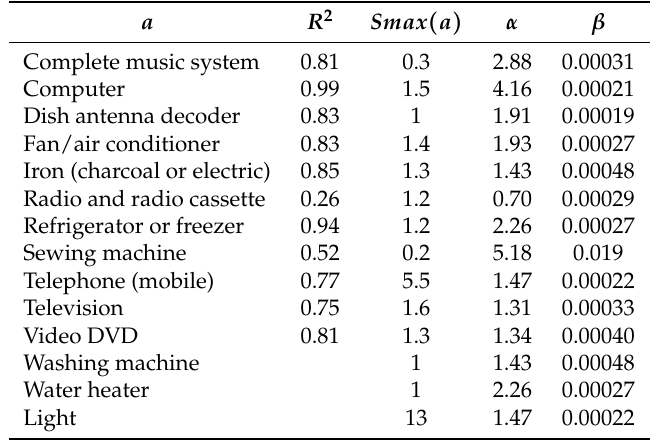
Table 1. Estimated parameters for each appliance in the electric appliance retention